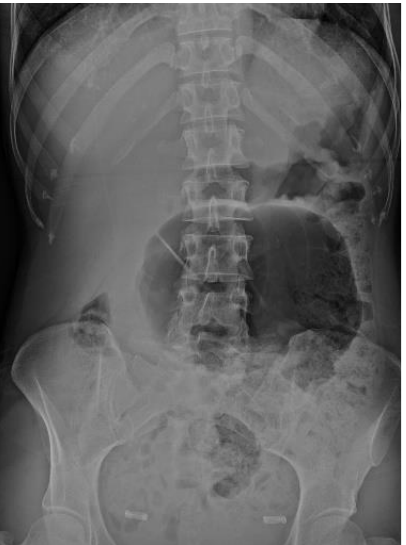
Figure 2. Abdominal radiograph again demonstrating classical features of CV. The patient was 15 days postoperative laparoscopic tubal ligation and surgical clips can be seen bilaterally in the